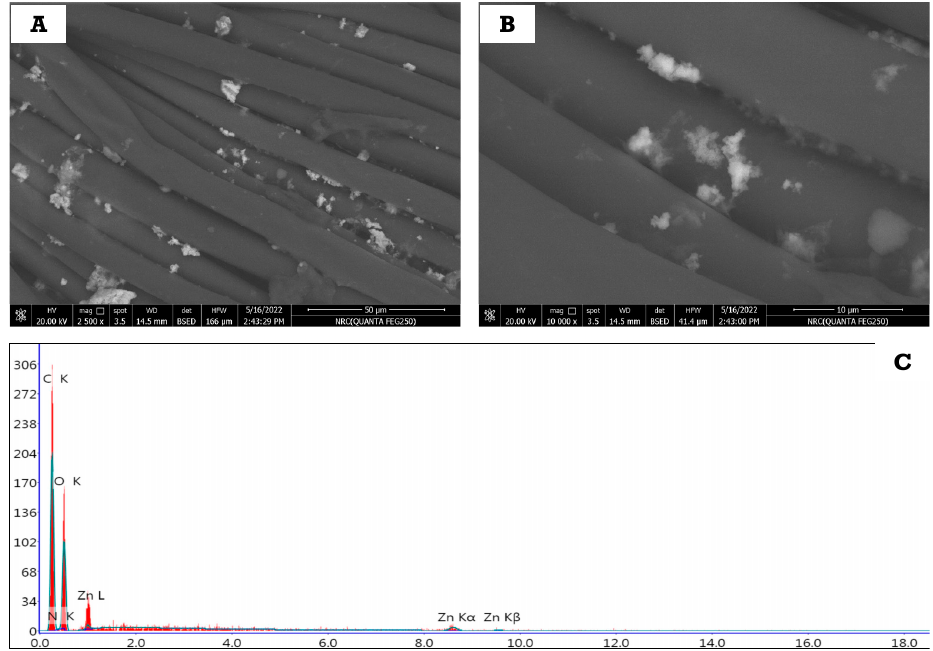
Figure 7. SEM at ( A ) 2500× and ( B ) 10,000×); ( C ) EDX of the treated cellulosic fabric with ZnONPs-2.